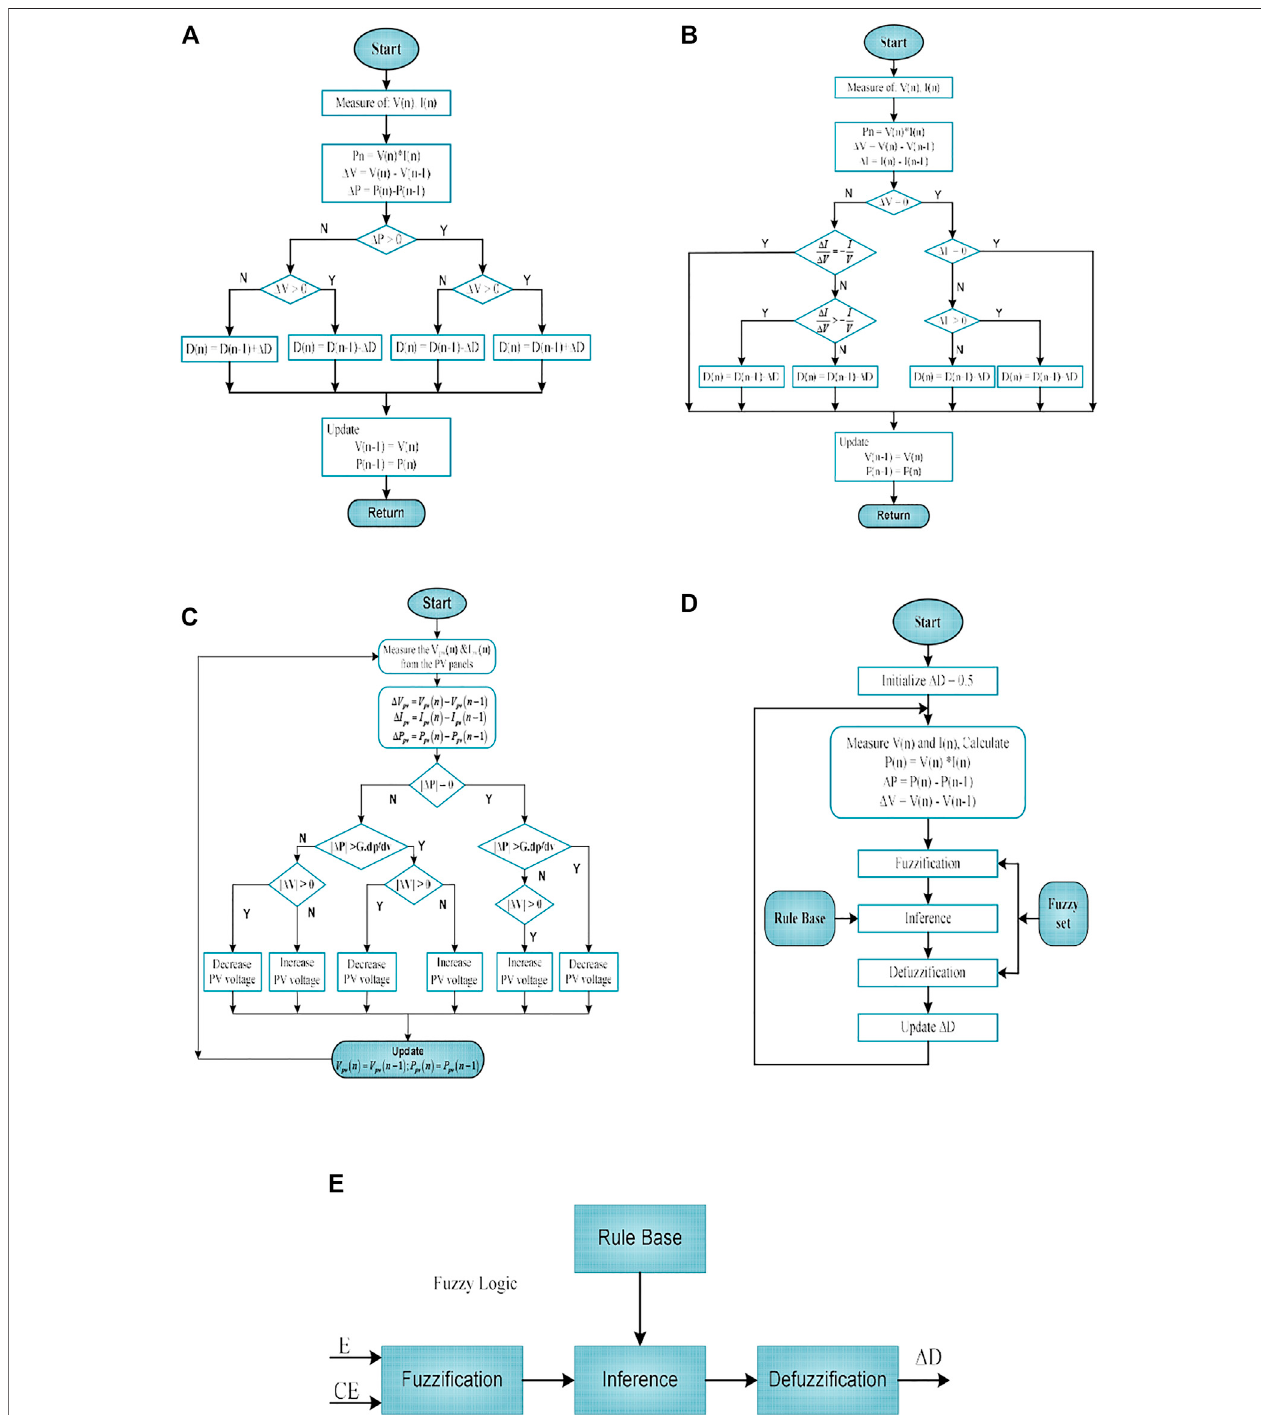
FIGURE 5 | Flow-chart ofthe four conventional MPPT techniques (A) P&O (Esram and Chapman, 2007) (B) Inc Cond (Li and Wang, 2009) (C) MP&O (Bayrak and Ghaderi, 2019) (D) FLC based MPPT (Saravanan and Ramesh Babu, 2016). (E) . Block diagram of FL-MPPT technique.